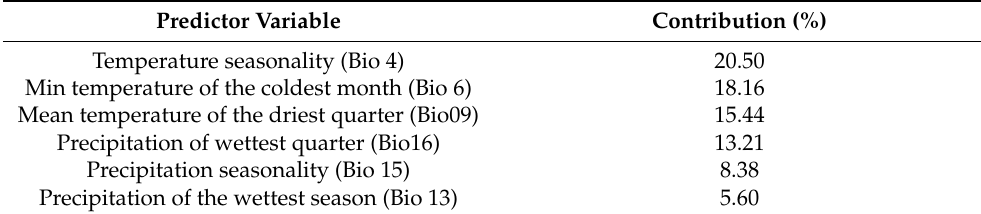
Figure 7. Distribution of all models, non-statistically significant models, and selected models. Table 8. Top predictors and their percentage contribution reported from the Maxent model for Pinus oocarpa